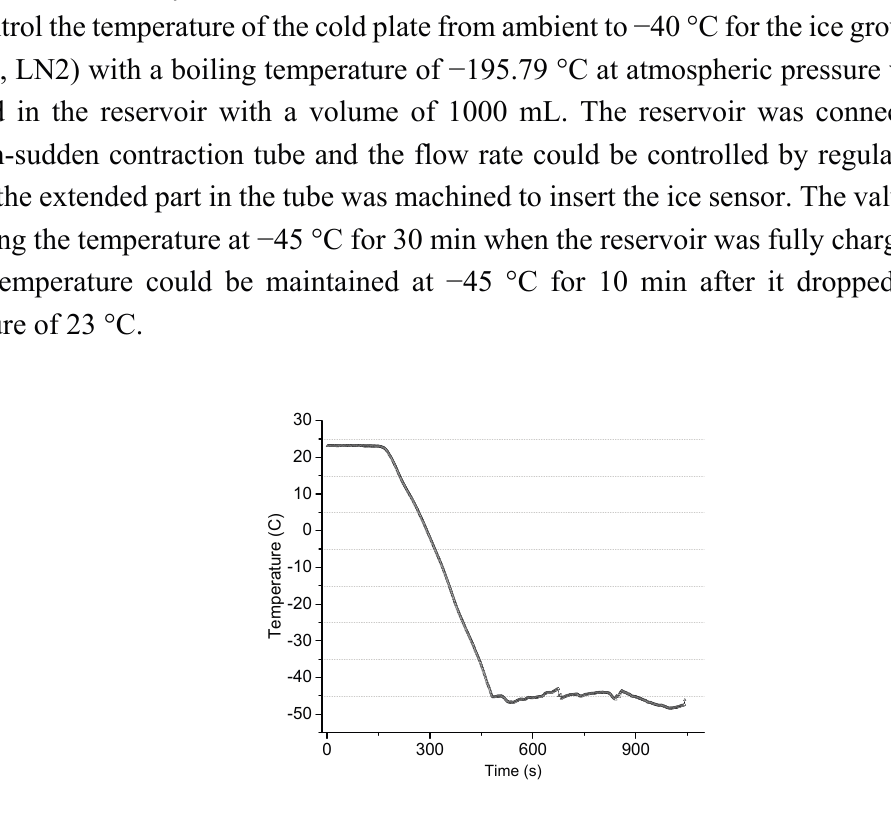
Figure 6. Cooling performance of the fabricated cooling chamber.